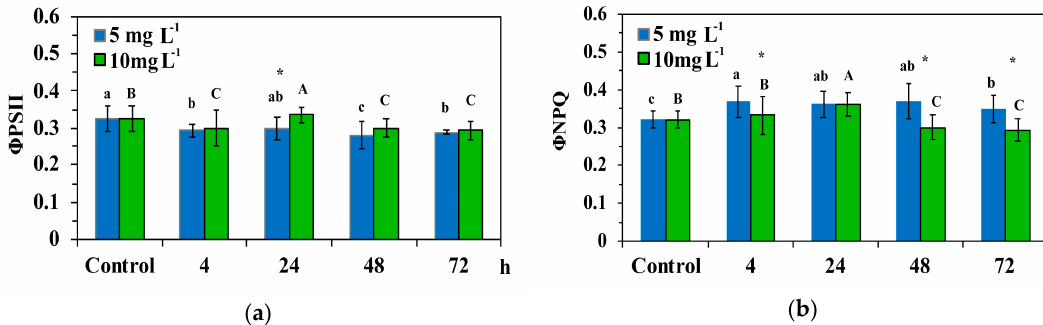
Figure 5. The quantum efficiency of PSII photochemistry ( Φ PS ΙΙ ) (a) ; and the quantum yield of regulated non-photochemical energy loss as heat ( Φ NPQ ) (b) , in control leaf blades of C. nodosa and in leaf blades exposed to 5 mg L − 1 and 10 mg L − 1 ZnO NPs for 4 h, 24 h, 48 h and 72 h. Columns with the same